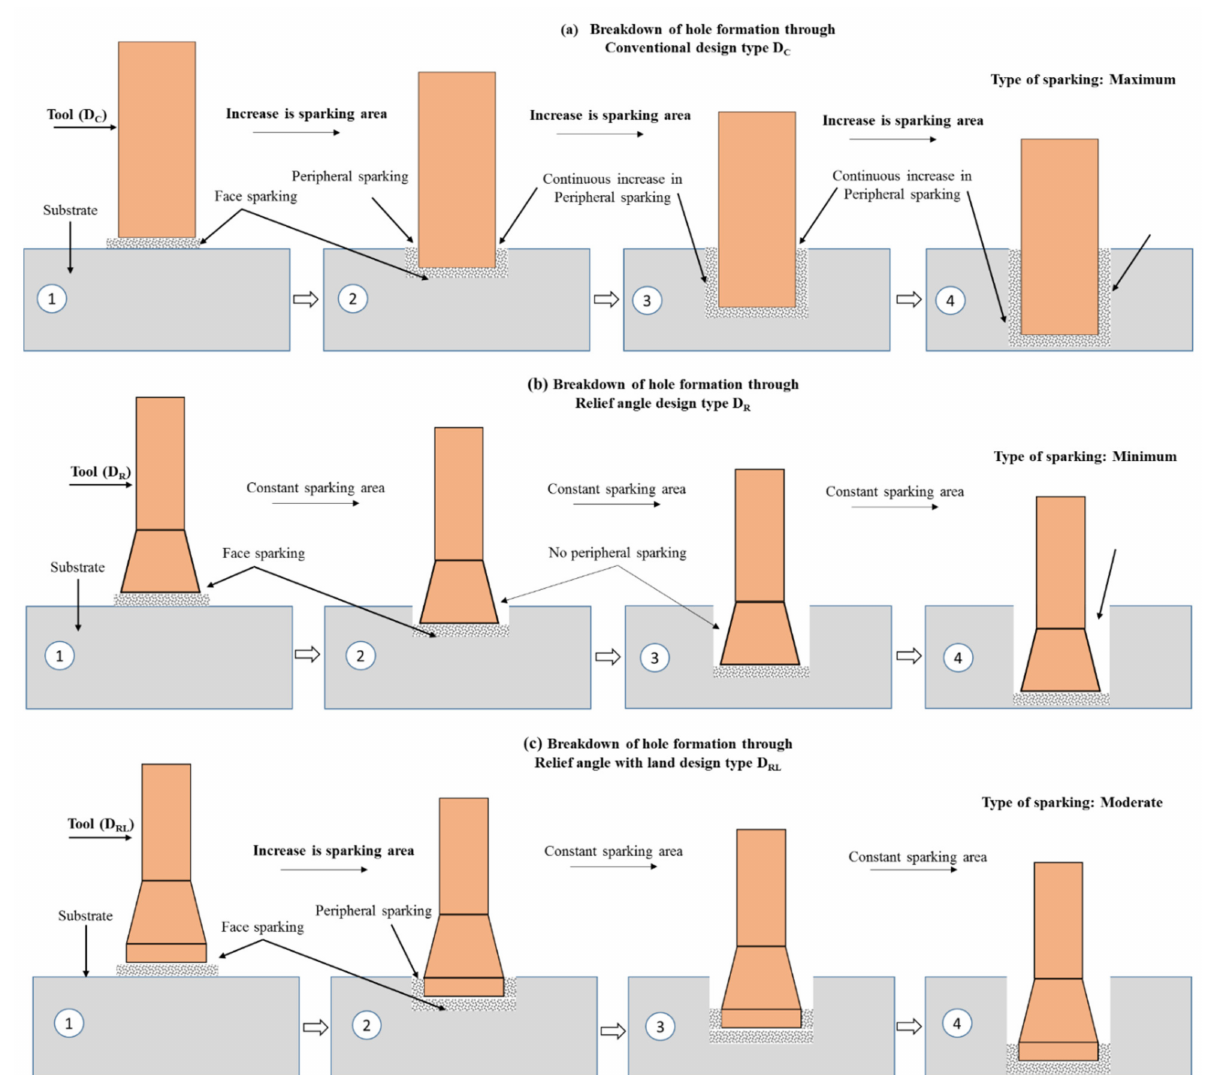
Figure 5. Breakdown of hole formation and sparking phenomenon: ( a ) design type D C , ( b ) design type D R , and ( c ) design type D RL